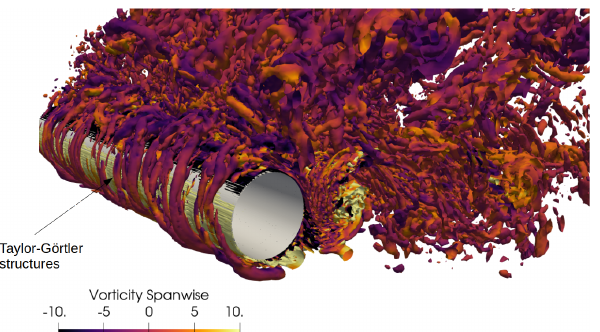
Figure 5. Taylor-Görler structures identified by iso-surfaces of the non-dimensional Q-criterion Q = 3 coloured with the span-wise vorticity for the case of U ∗ =